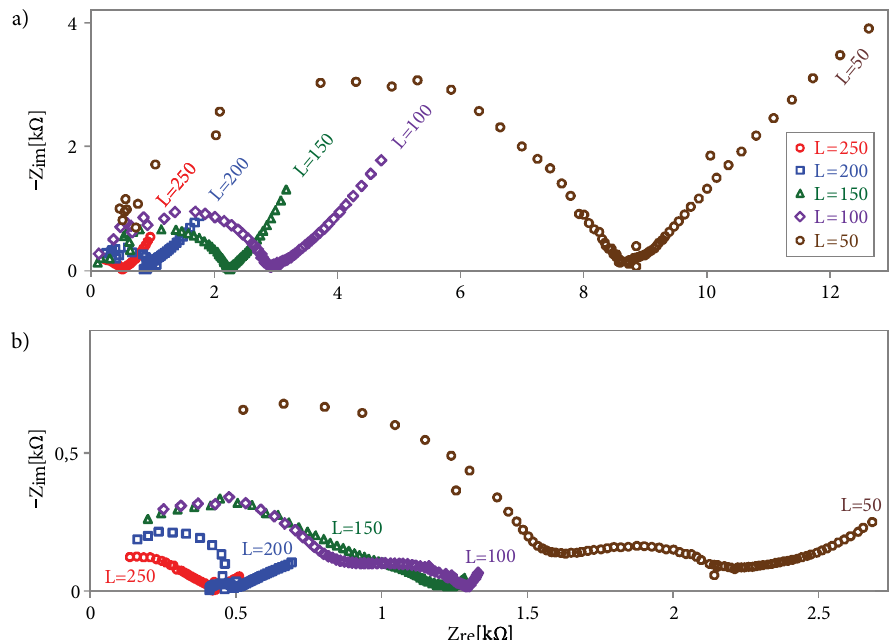
Fig. 4. Summary of the Nyquist plot of impedance spectra for different lengths of reinforcement in concrete: a) without additives, b) with the addition of 2% CaCl